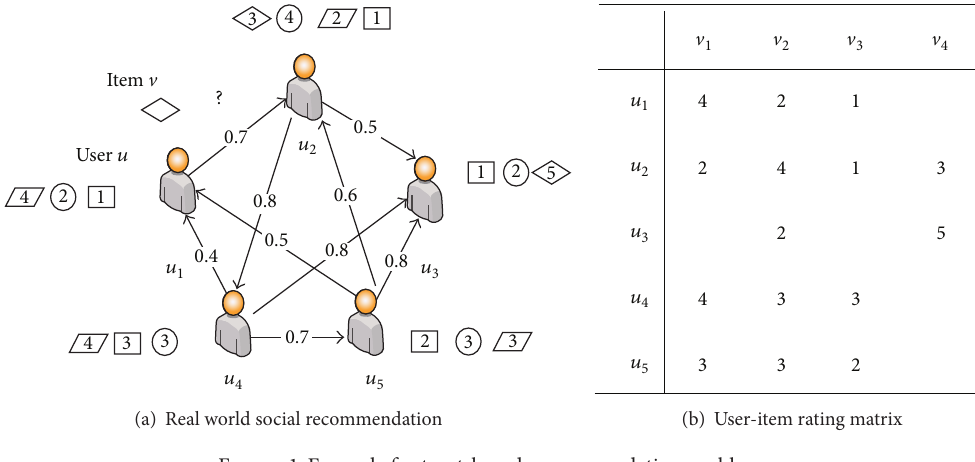
Figure 1: Example for trust-based recommendation problems.